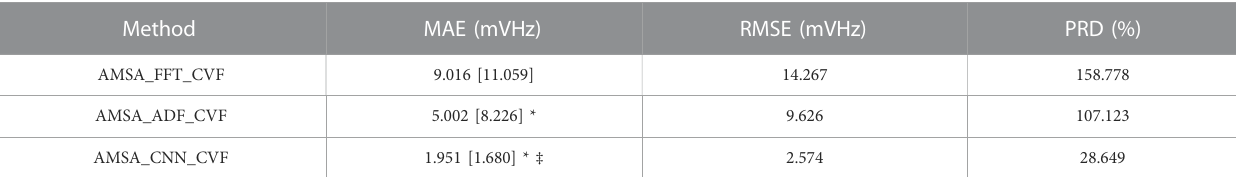
TABLE 3 Performance of different AMSA estimation method using test data.